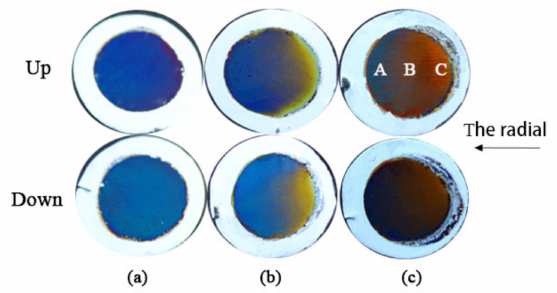
Figure 4. Digital images of twin alumina-Co composite films under different deflecting voltages: ( a ) 4 V, ( b ) 5 V, ( c ) 6